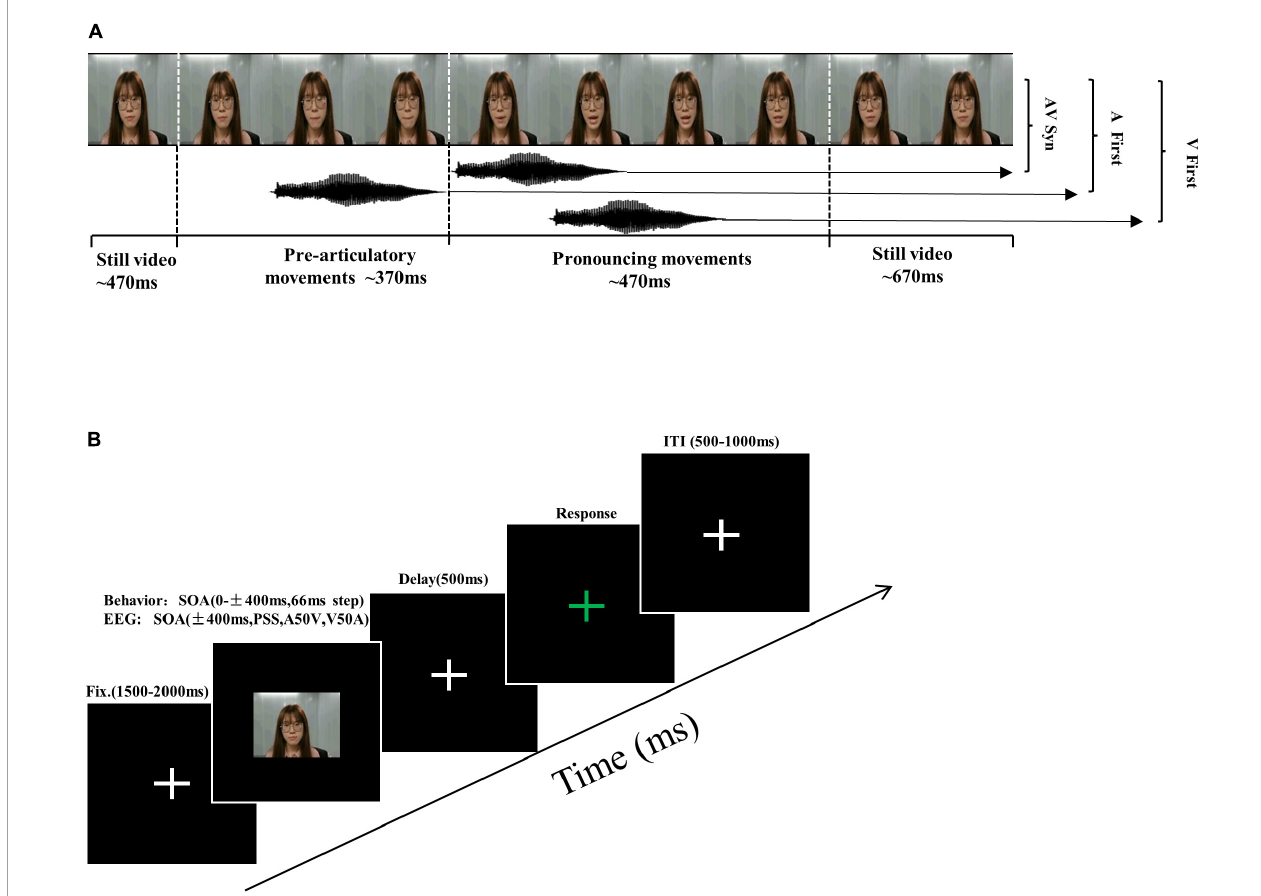
FIGURE1 Schematic of trial types and experimental procedure. (A) Different stimulus onset asynchronous (SOA) stimuli conditions were created by adjusting the relative onset time of the acoustic tracks and the visual frames. The SOA in which the acoustic signal is presented before the mouth just opened was defined as auditory leading SOA. The SOA in which the acoustic signal is presented after the mouth just opened was defined as visual leading SOA. The original movie in which the acoustic signal is presented at the same time with the mouth just opened was defined as 0 ms SOA. (B) Overview of structure and timing of a single trial. Participants provided non-speeded, two-alternative forced-choice (2AFC) simultaneity judgments in the response interval.